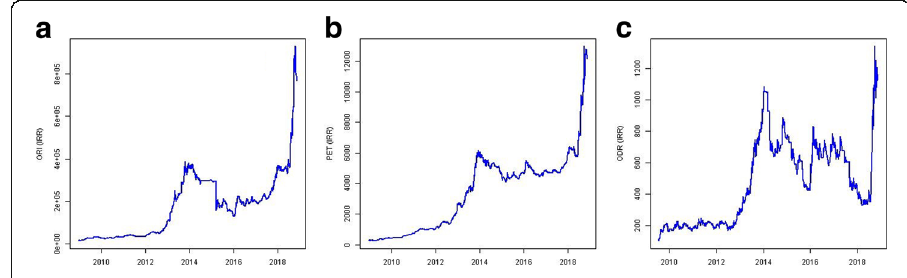
Fig. 1 The equity sector data for ORI ( a ), PET ( b ), and ODR ( c )